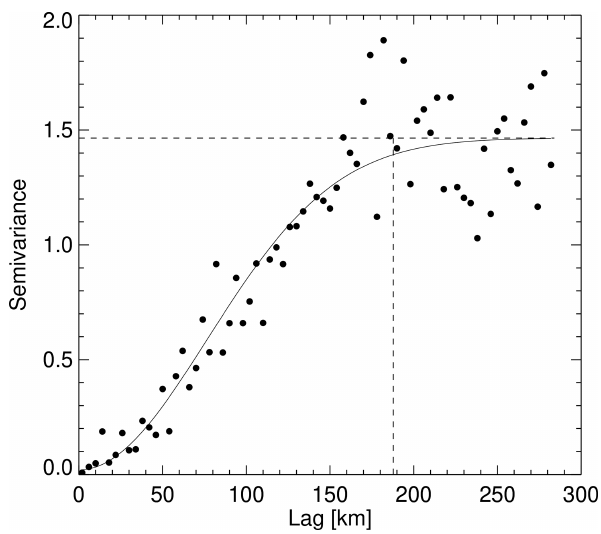
Figure 6. Experimental semivariogram of log-transformed smoothed SMB observations (dots), Gaussian fit model (black solid line), and sill and practical range parameter (dashed lines).